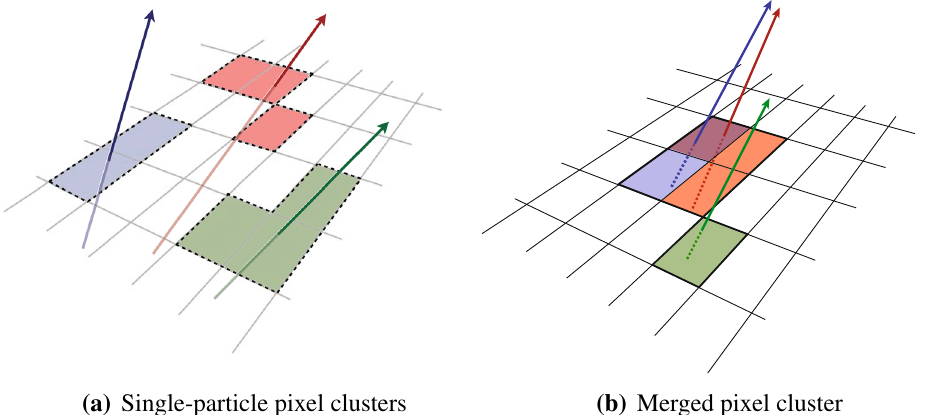
Fig. 2 Illustration of a single-particle pixel clusters on a pixel sensor and b a merged pixel cluster due to very collimated charged particles. Different colours represent energy deposits from different charged particles traversing the sensor and the particles trajectories are shown as